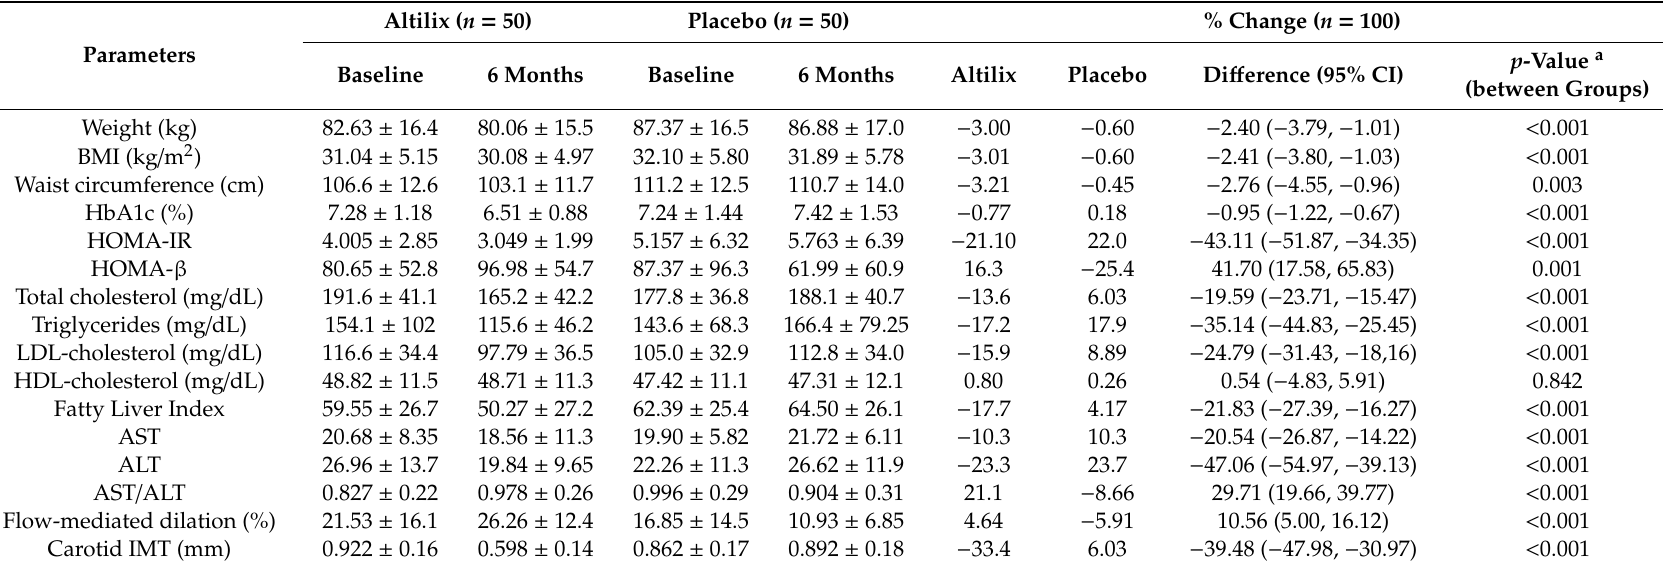
Table 2. Cardiometabolic parameters at baseline and at the end of the study ( n =